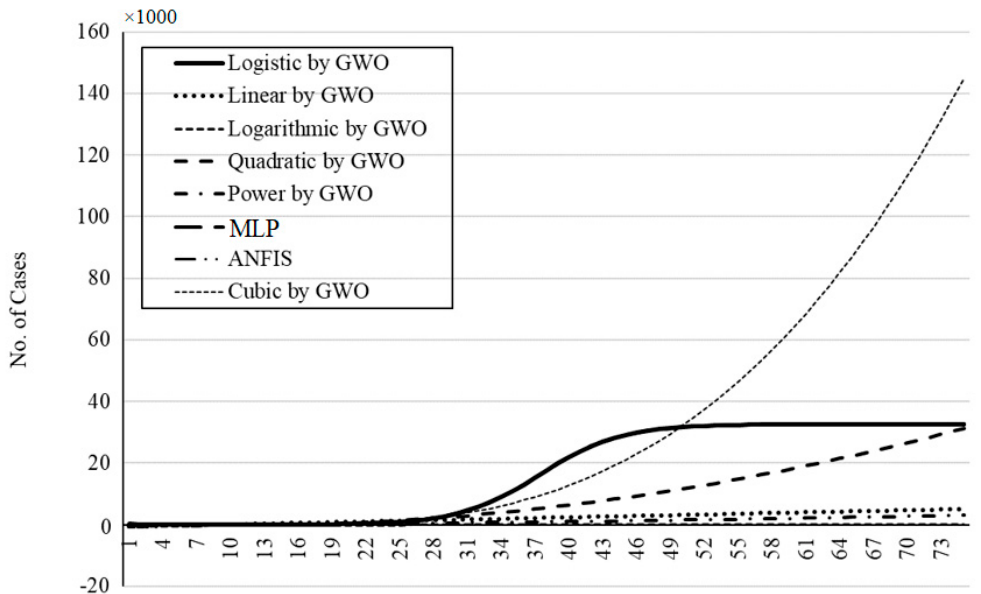
Figure 26. The outbreak prediction for the USA through 75 days. Table 17. The outbreak prediction for Italy through 150 days.